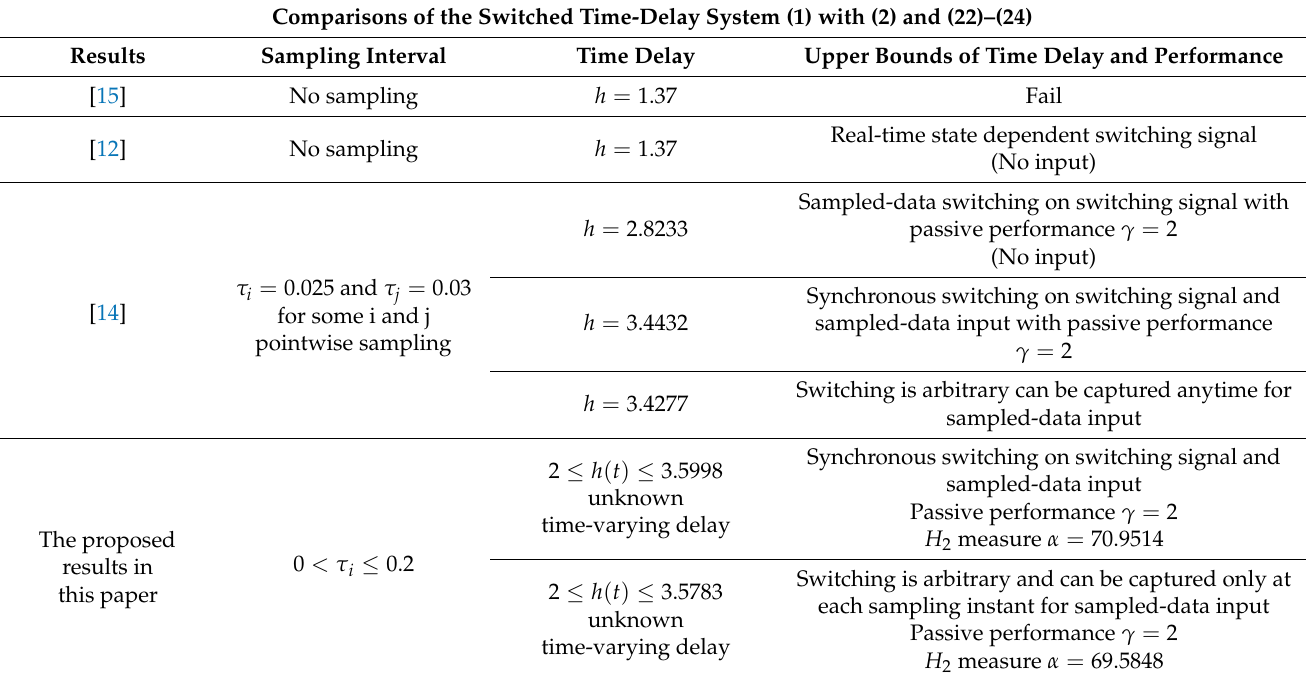
Table 3. Comparing previous results with this